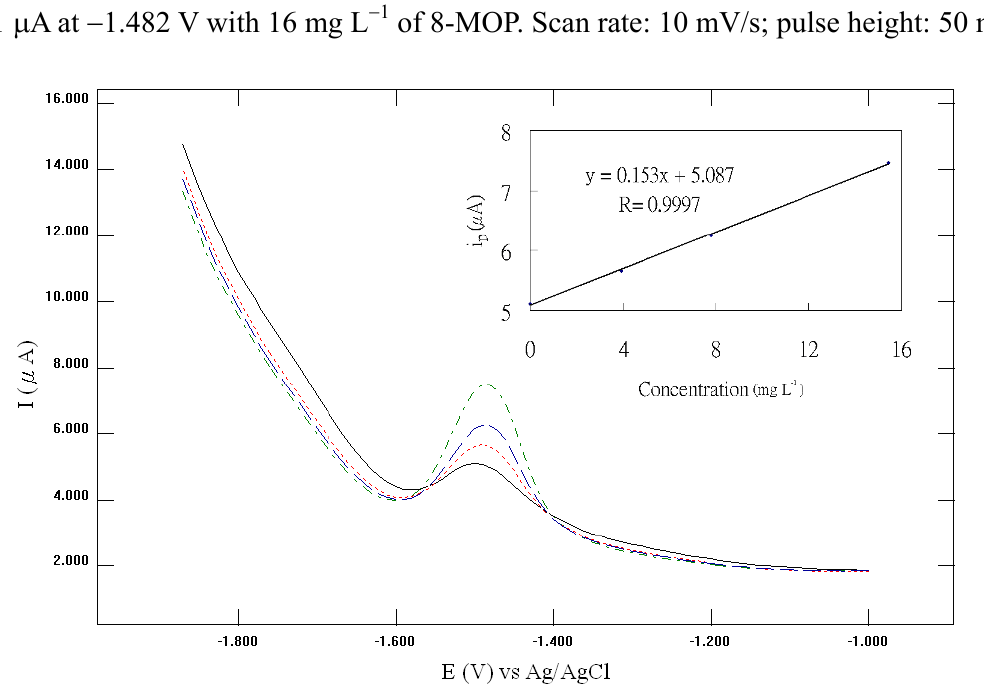
Figure 6. DPV for 8-MOP from Angelicae dahuricae at an Hg/GCE using a standard addition procedure. The peak current values were (i) solid line: 5.114 μ A at − 1.490 V with 0 mg L − 1 of 8-MOP; (ii) dashed line: 5.659 μ A at − 1.488 V with 4.0 mg L − 1 of 8-MOP; (iii) dotted line: 6.256 μ A at − 1.482 V with 8.0 mg L − 1 of 8-MOP; and (iv) dashed/dotted line: 7.461 μ A at − 1.482 V with 16 mg L − 1 of 8-MOP. Scan rate: 10 mV/s; pulse height: 50